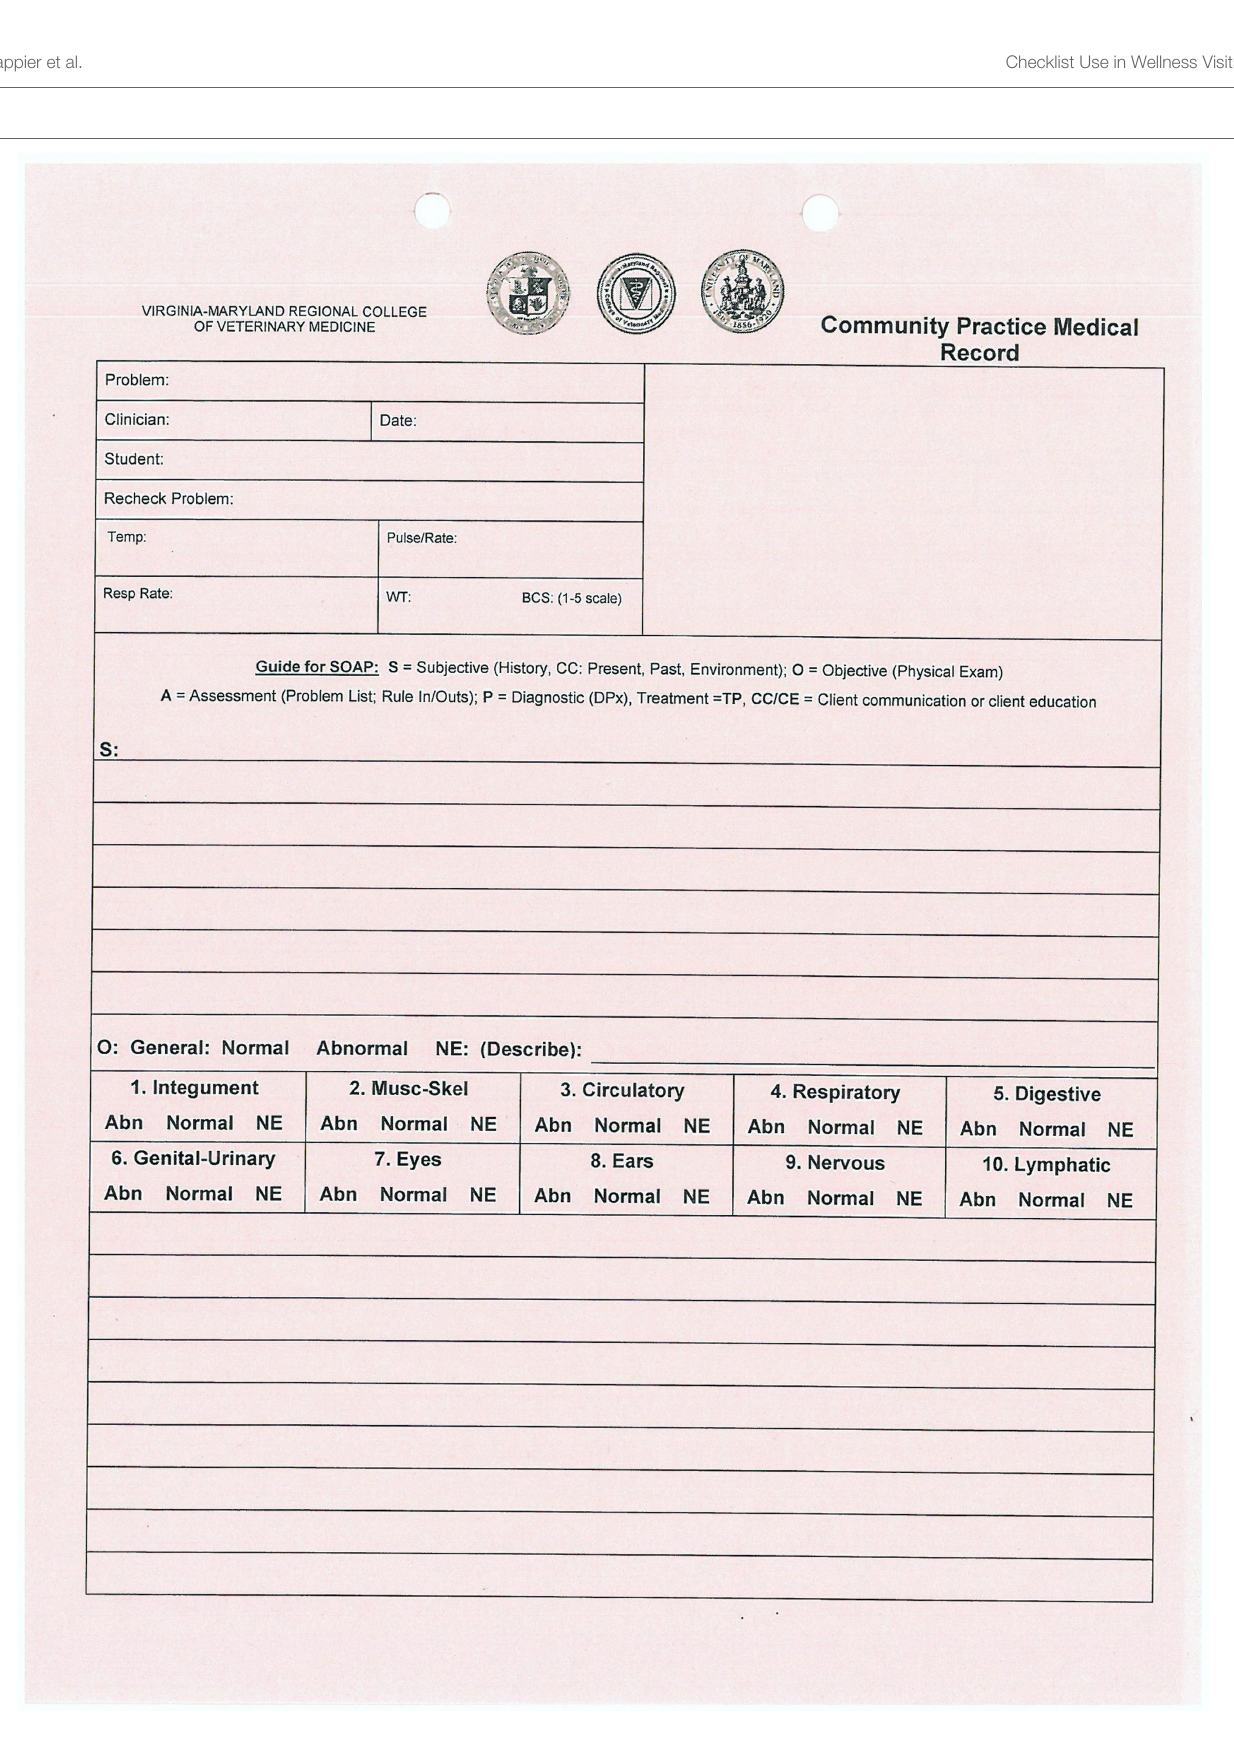
FigUre 1 | Example of student paper record